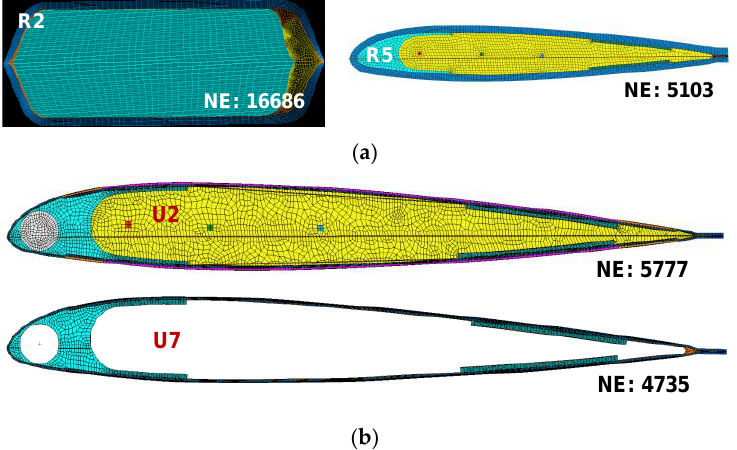
Figure 9. FE meshes at the selected sections of the blade (NE: number of elements). ( a ) Blade root sections and ( b ) blade airfoil